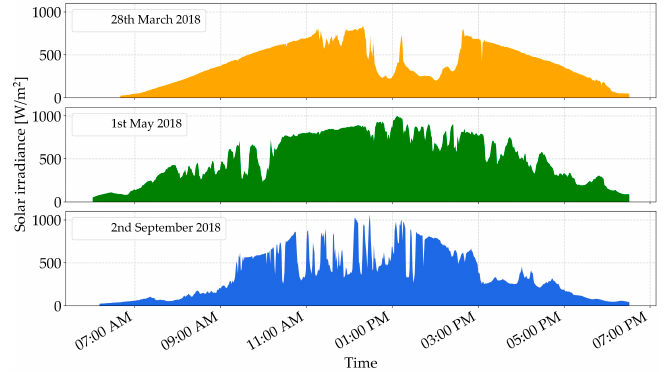
Figure 8. Diagram of solar irradiance profiles on 28 March 2018, 1 May 2018, and 2 September 2018. Energies 2020 , 13 , x FOR PEER REVIEW 12 of 18